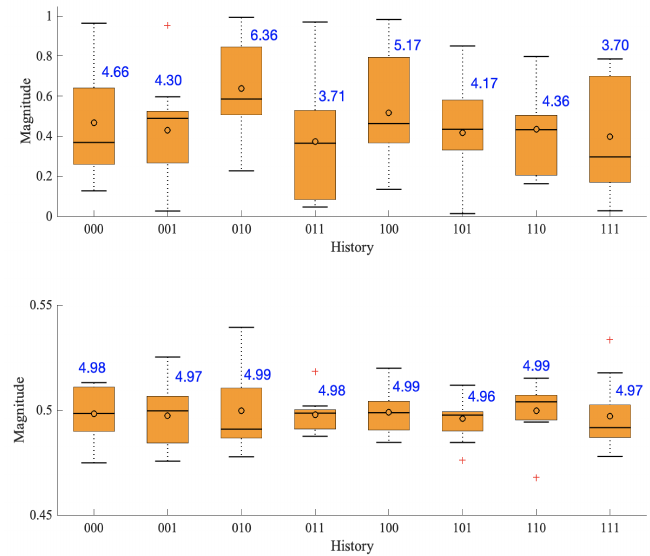
Figure 3. Range of demands at generation 0 (top) and generation 200 (bottom). Note the ordinate axis scaling is different in the two plots. The blue numbers next to each box indicates the demand total. The ‘+’ symbol indicates data